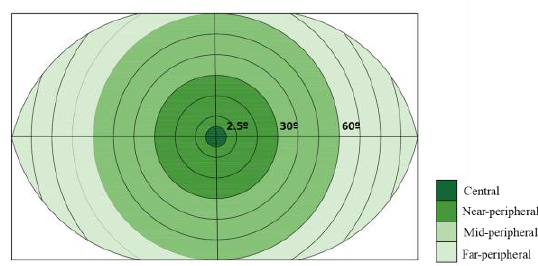
Figure 4. Human visual field.